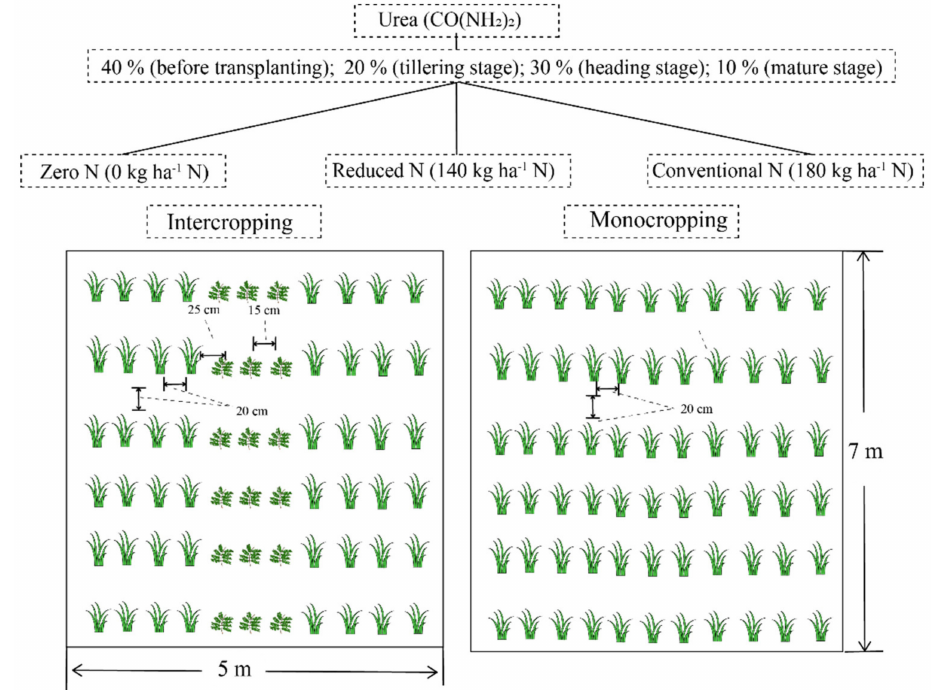
Figure 1. Experimental design of two cropping systems under three different levels of N fertilizer application